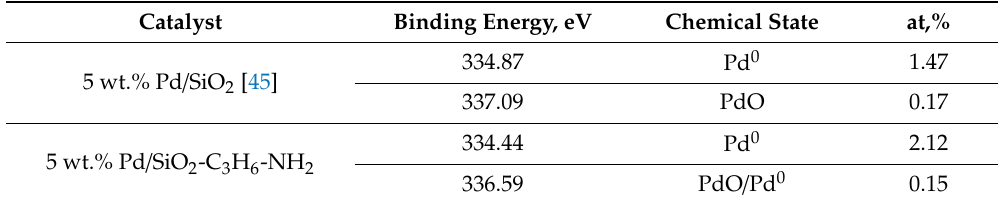
Table 2. The spectrum data of catalysts before the reaction.